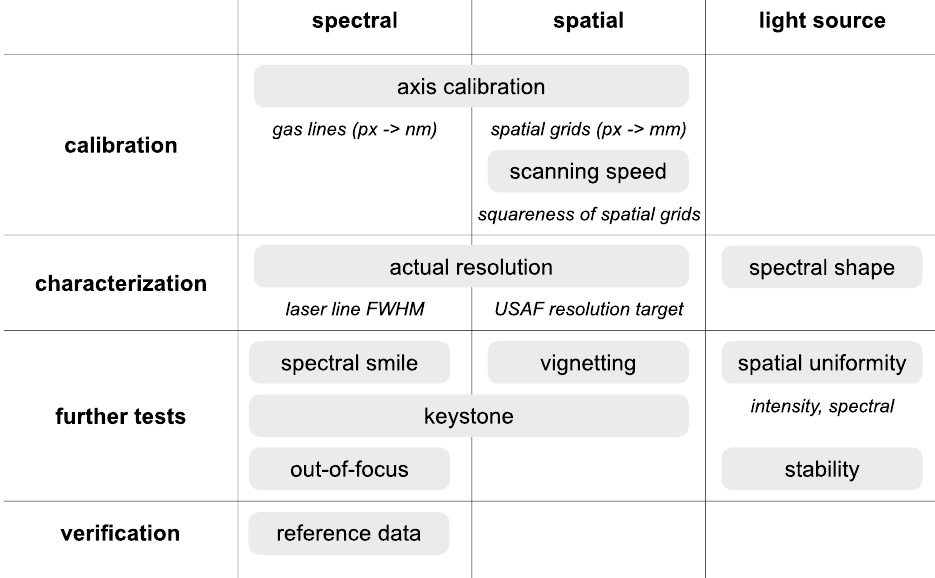
Figure 2. Outline of calibration, characterization, verification and further testing. In the calibration step, the spatial and spectral axes are calibrated using references; for the push-broom system, scanning speed is also calibrated. As part of the characterization step, actual spectral and spatial resolutions are determined, along with the spectral shape of the light source. Further steps include testing for spectral smile (bending of the spectral axis), keystone (different magnifications at different parts of the spectral axis), out-of-focus behavior and vignetting (darkening of the peripheral regions); additionally, light sources should be tested for spatial uniformity, both in terms of their intensity and spectral properties as well as temporal stability. In the verification step, the system is verified against known reference data, such as ink samples with known absorption